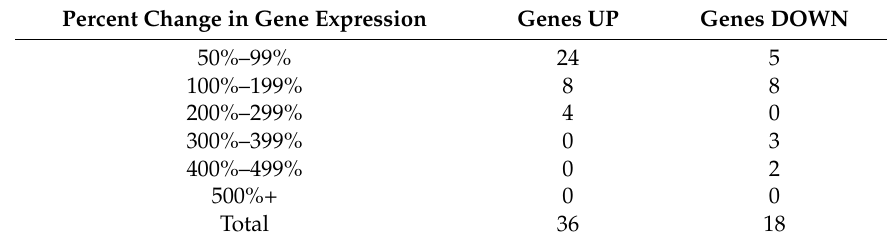
Table 21. Distribution of Genes Affected by GHK and Associated with Myelin.